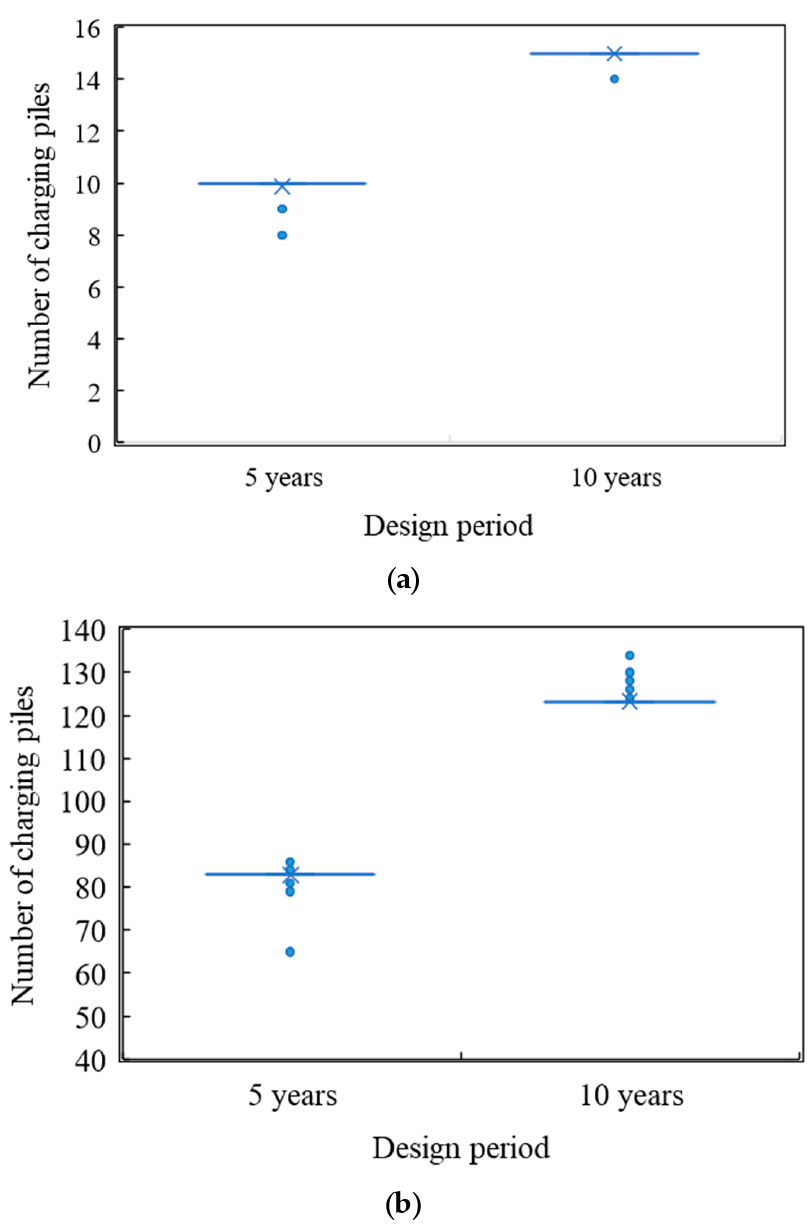
Figure 4. Optimal configuration results of charging piles for the two office buildings: ( a ) Scientific research office building; ( b ) Commercial office building.